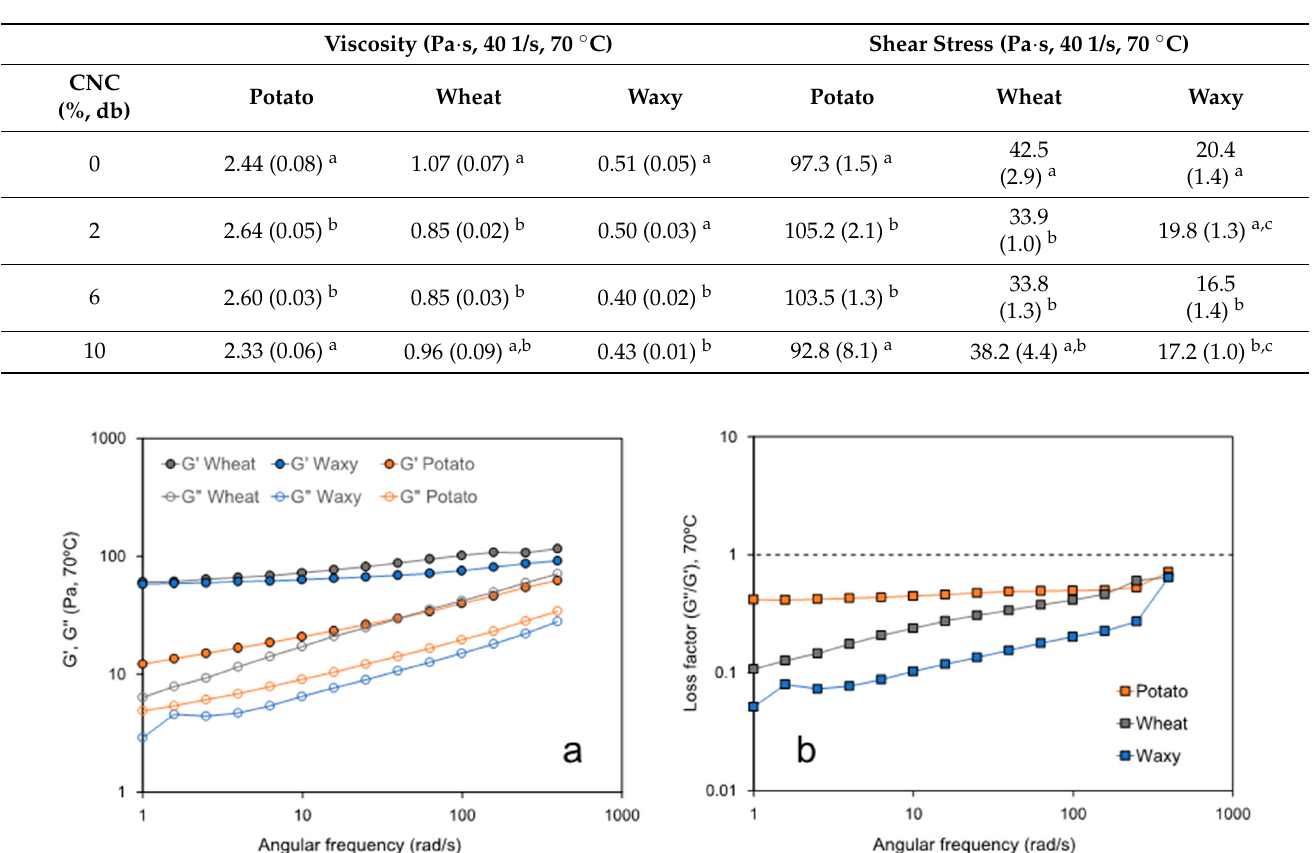
Table 2. Apparent viscosity and shear rate of starch–CNC blends assessed at a shear rate of 40 1/s and 70 ◦ C. Values in brackets correspond to standard deviation. Different upper letters in the same column represent significant differences ( p -value < 0.05).